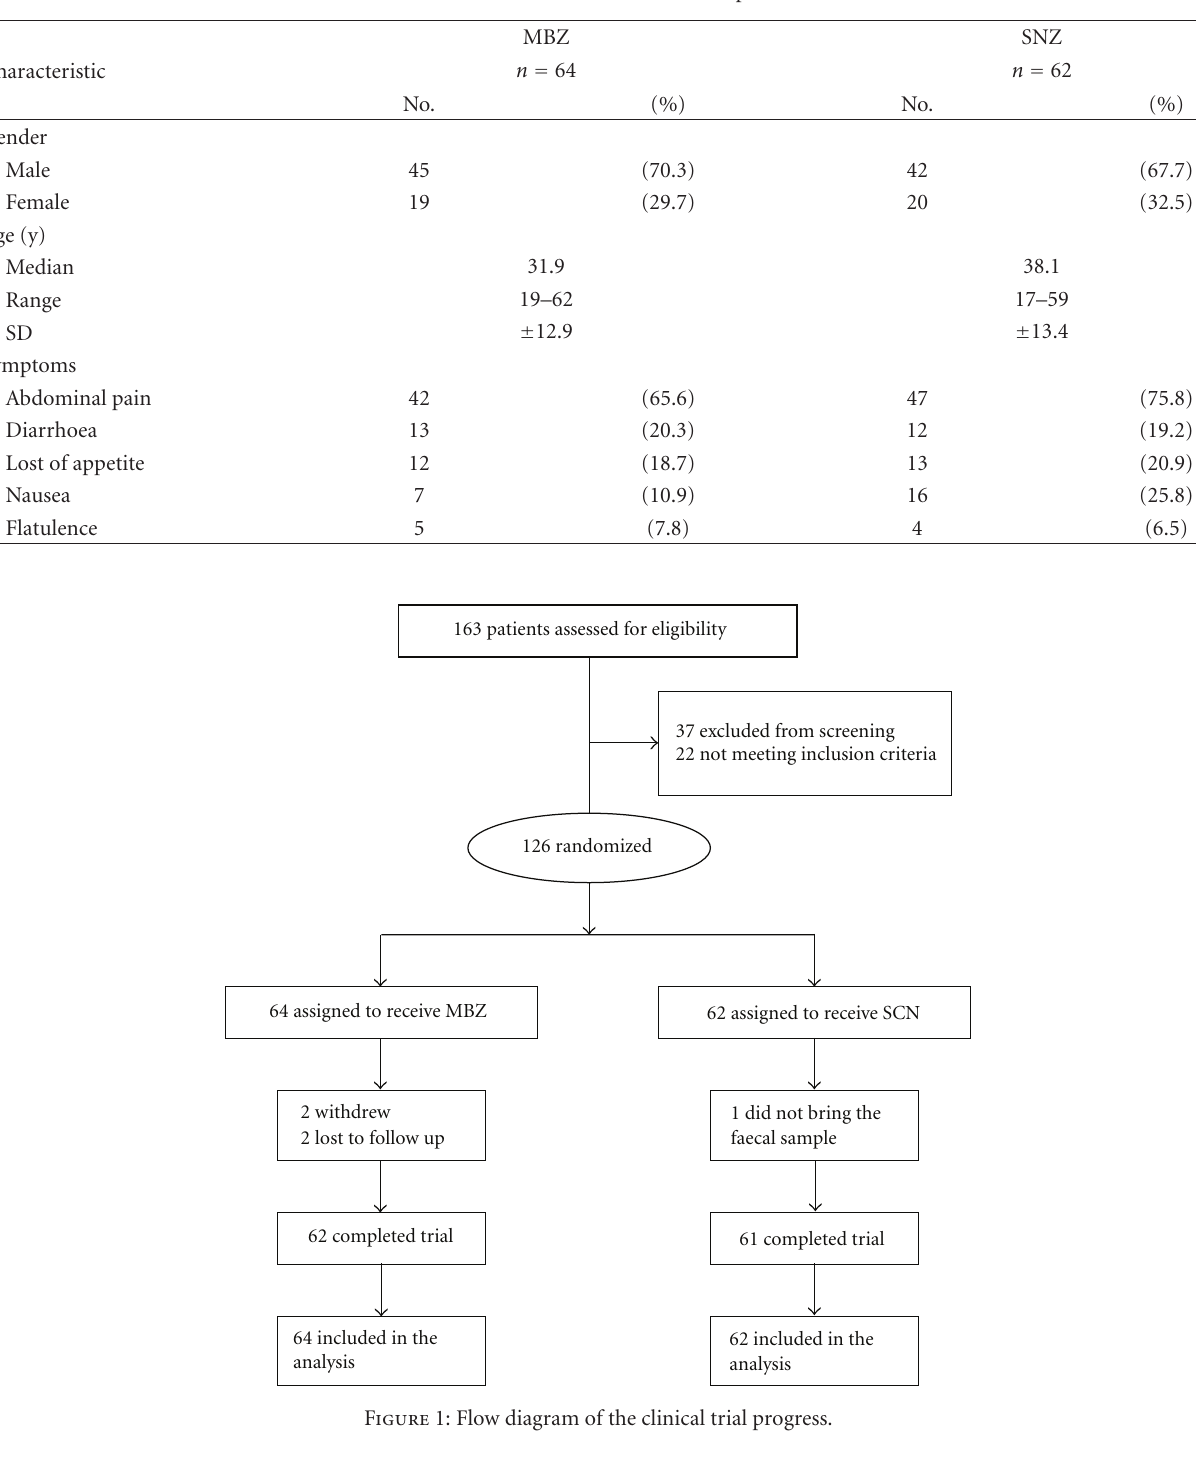
Table 1: Baseline characteristics of the patients.